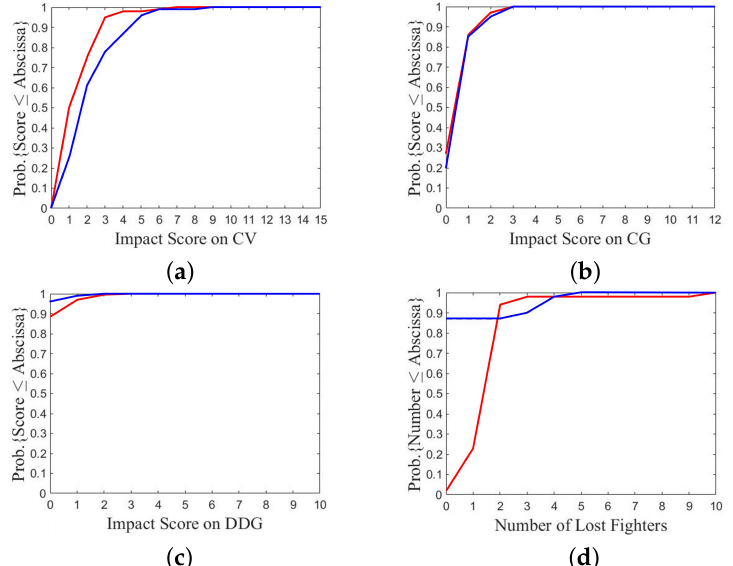
Figure 14. (A3/B3) Cumulative distribution of impact score on ( a ) CV ( b ) CG, (c) DDG, ( d ) fighters; over 100 games with one P 2 SO run, ———: fleet A, ———: fleet